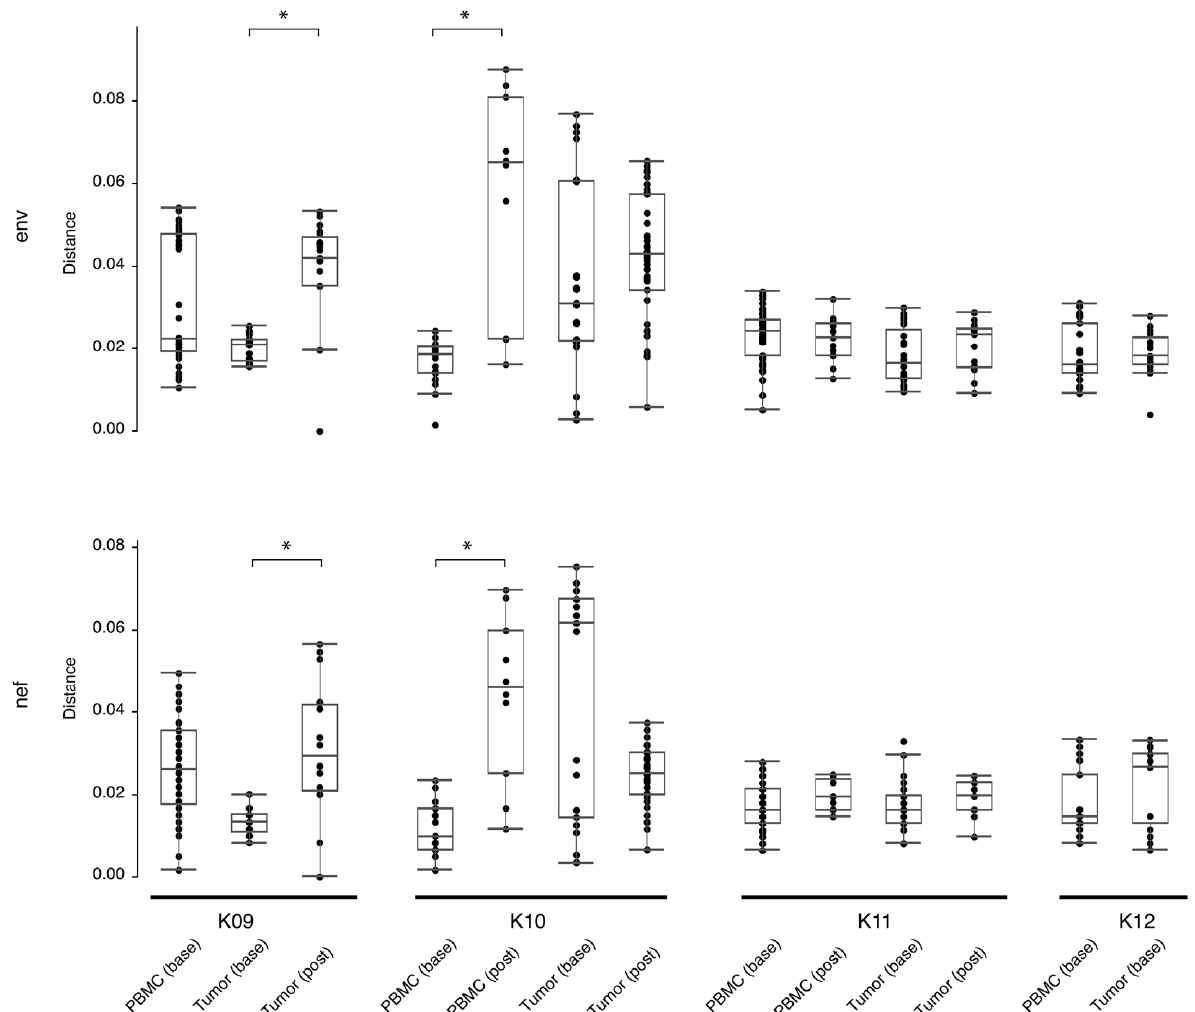
Figure 1. Estimates of evolutionary divergence between sequences from PBMCs and tumors, at